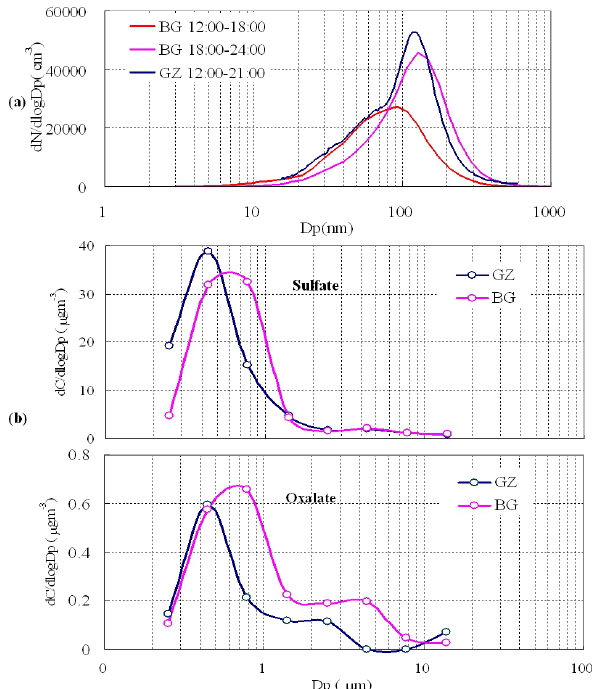
Fig. 7. Average particle number size distributions on 21 July (a) and average mass size distributions of sulfate and oxalate from 06:30LT, 21 July to 06:00LT, 22 July (b) at GZ and